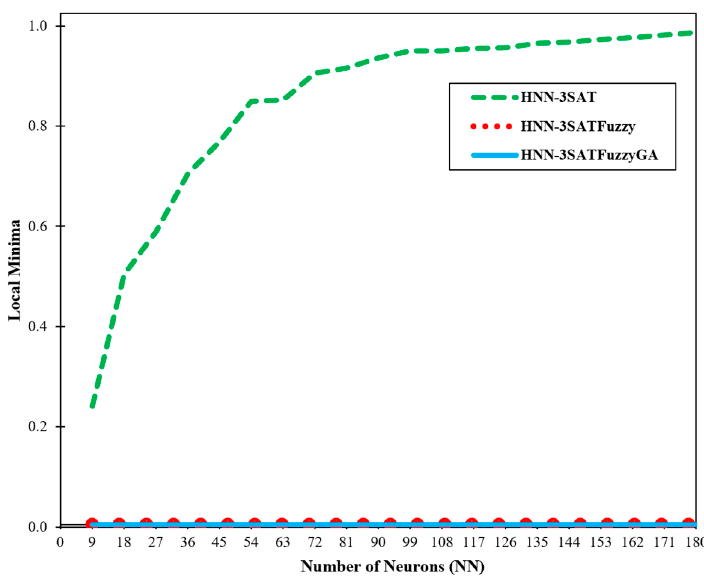
Figure 8. Local minima ratio (yM).